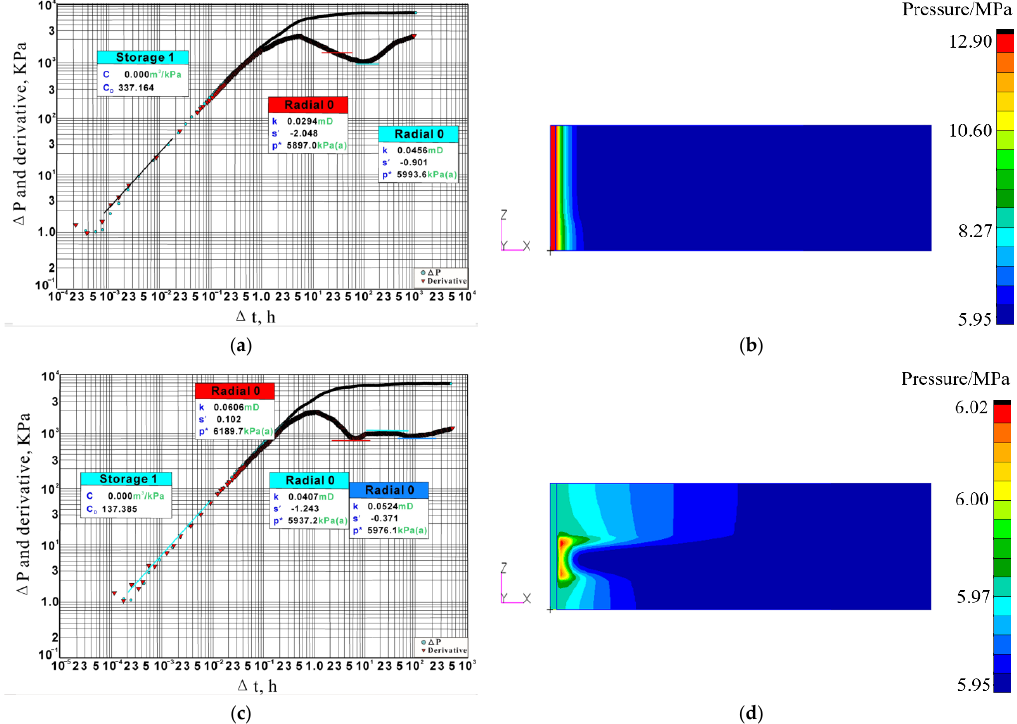
Figure 15. ( a ) The derivative plot of the two-layer model; ( b ) The pressure profile of bottom-hole pressure for the two-layer model; ( c ) The derivative plot of the three-layer model; ( d ) The pressure profile of bottom-hole pressure for the three-layer model.